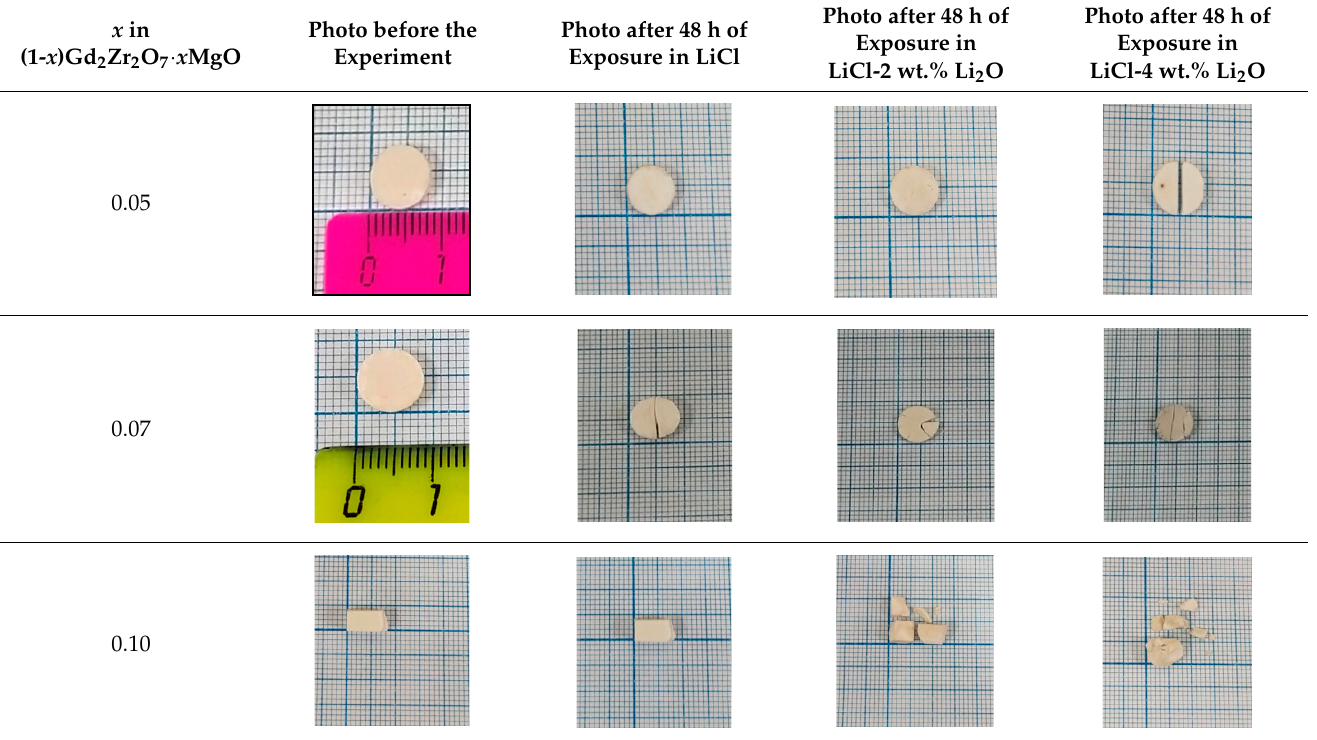
Table 4. Photographs of the obtained ceramic samples of (1- x )Gd 2 Zr 2 O 7 · x MgO before and after exposure in LiCl- x Li 2 O melts at T = 650 °C.